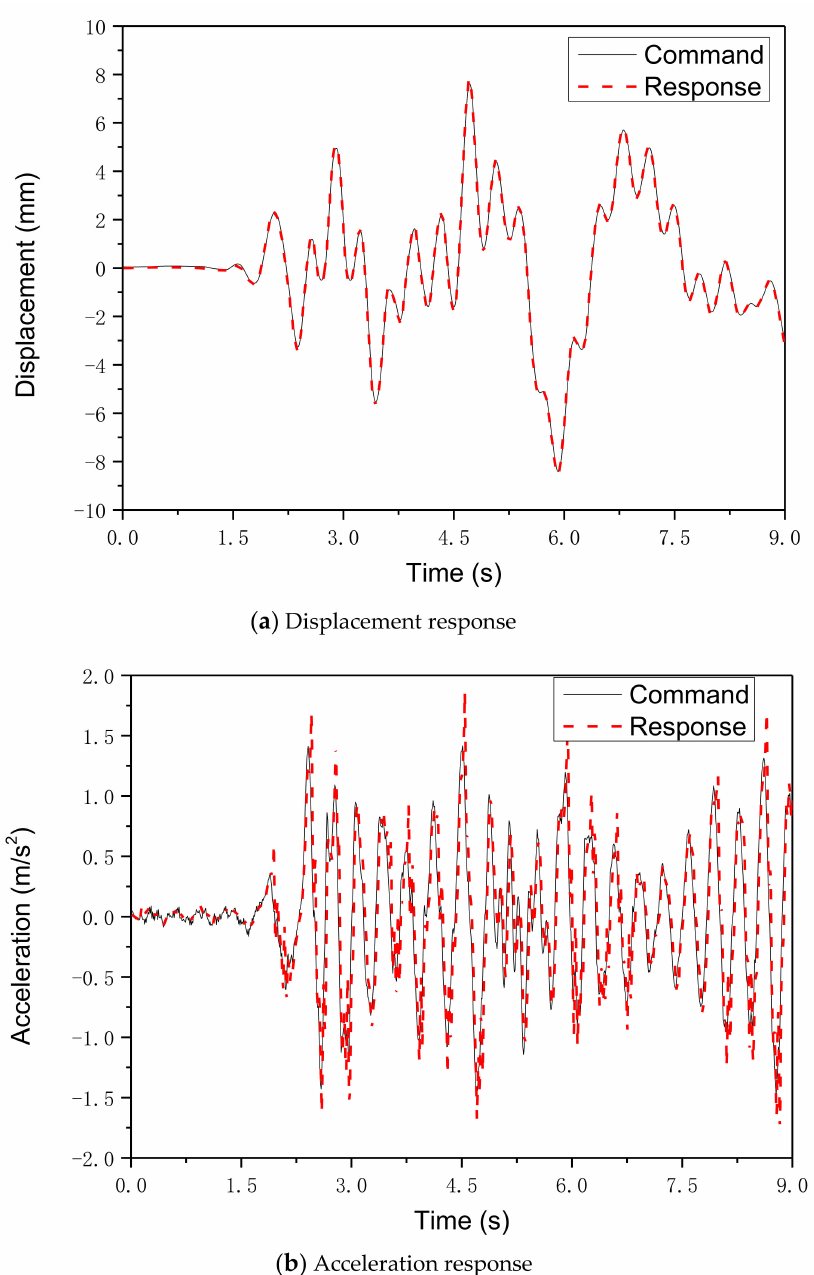
Figure 9. Shaking table substructure testing (STST) results with a three-variable control method with velocity positive feedback